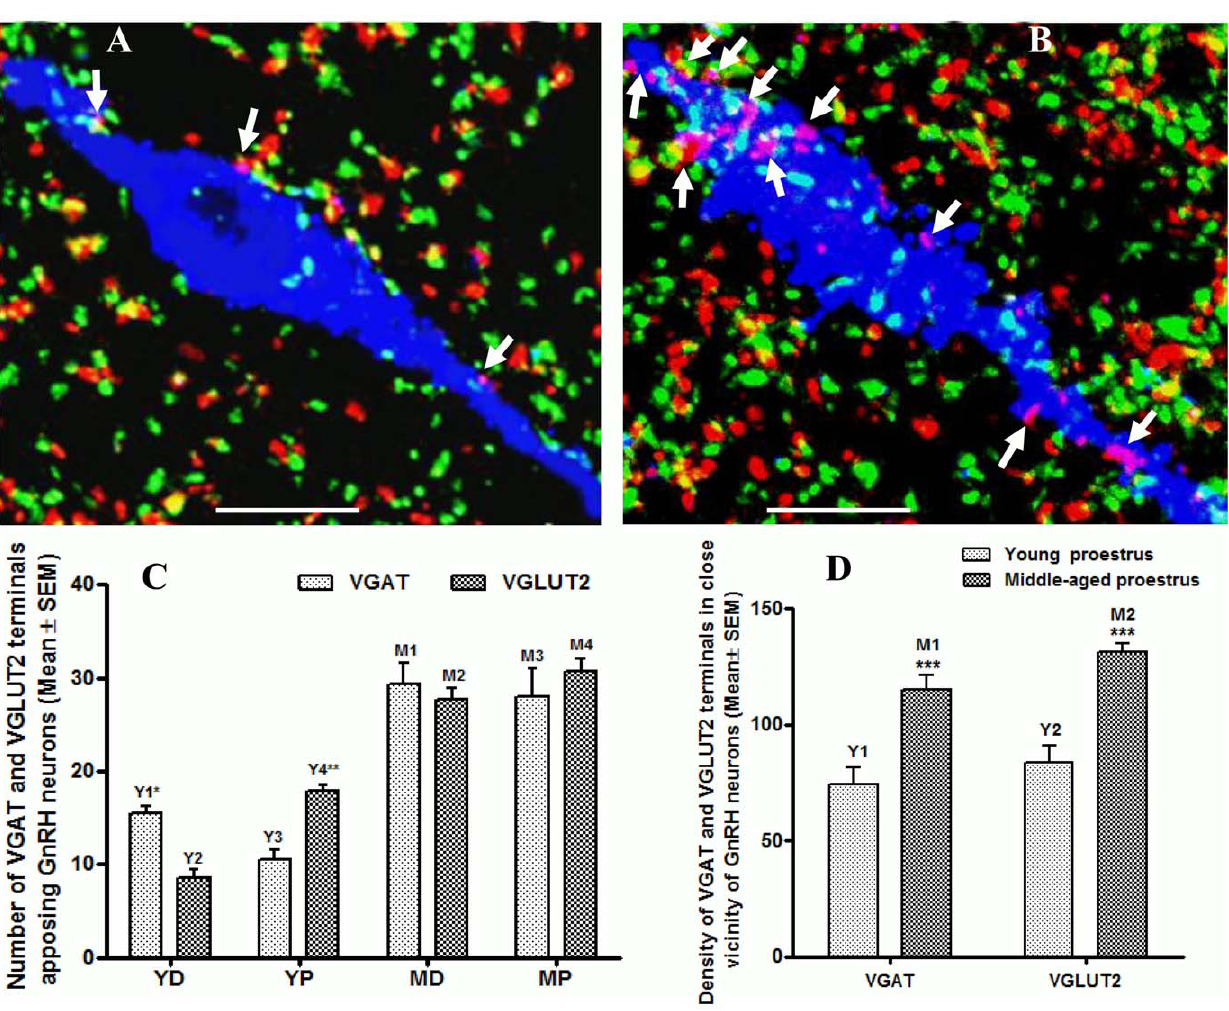
Figure 3. Cycle and age-dependent changes in VGAT and VGLUT2 terminals apposing GnRH neurons. Figure 3A and B, confocal images showing expression of VGAT (red), VGLUT2 (green) and GnRH neuron (blue) from a young (Figure 3A) and middle-aged (Figure 3B) proestrus female rat, respectively. Figure 3C, shows statistical analysis of VGAT and VGLUT2 synaptic terminals apposing GnRH neurons. In young animals at diestrus, average VGAT terminals apposing GnRH neurons were significantly ( P , 0.001) higher (Figure 3C; bar Y1) than VGLUT2 terminals (Figure 3C; bar Y2). However, at proestrus afternoon, VGAT terminals apposing GnRH neurons were significantly ( P , 0.01) decreased (Figure 3C; bar Y3) whereas VGLUT2 terminals (Figure 3C; bar Y4) were significantly increased ( P , 0.001). In middle-aged animals at diestrus, average VGAT terminals (Figure 3C; bar M1) apposing GnRH neurons were not statistically different ( P . 0.05) from the number of VGLUT2 terminals (Figure 3C; bar M2). Similarly, at proestrus, the number of VGAT terminals (Figure 3C; bar M3) apposing GnRH neurons were also not statistically different ( P . 0.05) from the number of VGLUT2 terminals (Figure 3C; bar M4). Furthermore, in either diestrus or proestrus middle-aged animals, average VGAT (Figure3B, and Figure 3C; bars M1 and M3) and VGLUT2 (Figure3B, and Figure 3C; bars M2 and M4) terminals apposing GnRH neurons were significantly higher ( P , 0.0001) compared to young either diestrus or proestrus animals (Figure 3C; bars Y1 andY3 for VGAT and bars Y2 and Y4 for VGLUT2). A further analysis at proestrus showed that in middle-aged animal, density of both VGAT (Figure 3B, and Figure 3D; bar M1) and VGLUT2 (Figure 3B, and Figure 3D; bar M2) terminals in the area in close vicinity of GnRH neurons was significantly ( P , 0.0001) increased compared to young animals (Figure 3A, and Figure 3D; bar Y1 for VGAT and bar Y2 for VGLUT2). Scale in Figure 3 A and B represents 10 m m. Various abbreviations used in Figure 3C are: YD (young diestrus), YP (young proestrus), MD (middle-age diestrus) and MP (middle-age proestrus) animal groups.